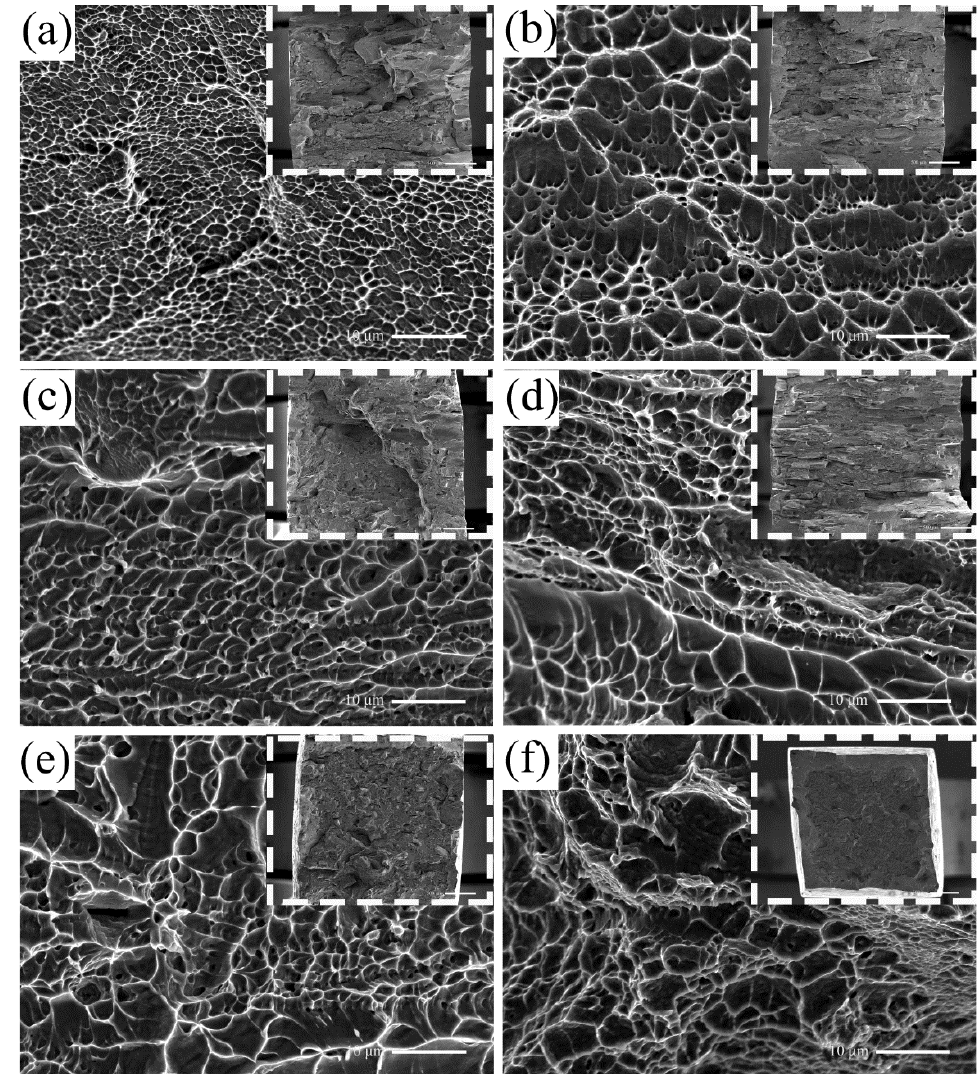
Figure 7. Fracture morphology of the annealed Zr – Ti – 8V alloys: ( a ) 400 °C, ( b ) 450 °C, ( c ) 500 °C, ( d ) 600 °C, ( e ) 700 °C, ( f ) 800 °C; the inset picture shows the overall shape of the fracture.